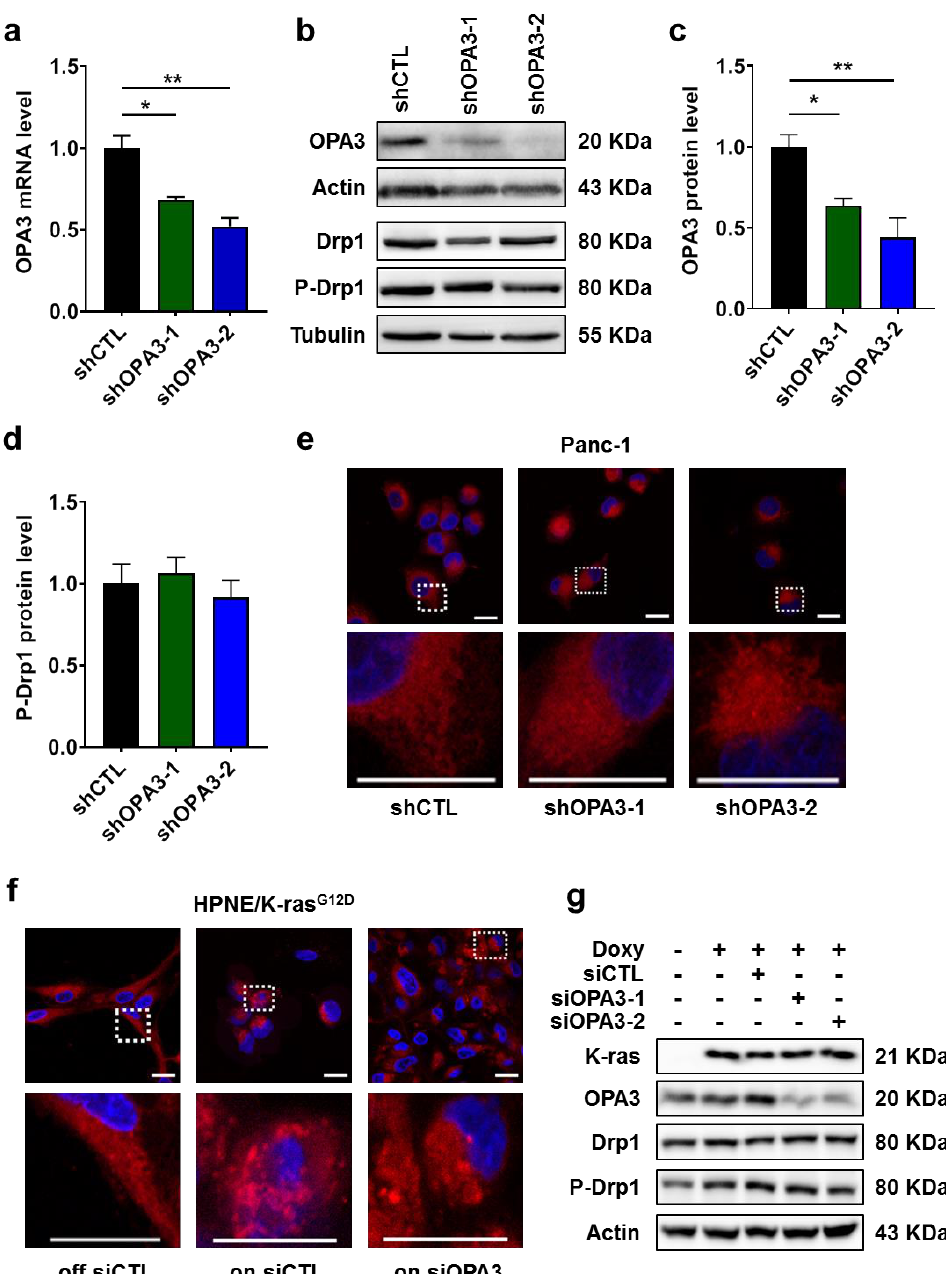
Figure 2. Silencing of OPA3 expression does not modify mitochondrial morphology: ( a ) OPA3 mRNA levels in Panc-1 OPA3-shRNA cell lines were measured by real-time PCR. ( b – d ) OPA3 and phospho-Drp1 (ser616) protein levels in Panc-1 OPA3-shRNA cell lines were analyzed by immunoblotting and quantified. ( e , f ) Mitochondrial morphology was analyzed with MitoTracker red probe in Panc-1 OPA3-shRNA cells and HPNE / K-ras G12D cells (with or without doxycycline and siRNA against OPA3). Scale bars represent 20 µ m ( g ) HPNE / K-ras G12D cell line was transfected with control siRNA (siCTL) or OPA3 for 48 h and then incubated with doxycycline for additional 48 h. K-ras, OPA3, Drp1, and phospho-Drp1 (ser616) protein levels were analyzed by immunoblotting. Statistics: data are mean ± S.E.M. (n = 3); one-way ANOVA followed by Dunnett post hoc test (compared to “shCTL”) for ( a ) and ( c , d ). * p < 0.05 and ** p < 0.01. Abbreviations: Drp1: dynamin related protein 1, K-ras: Kirsten RAS GTPase, OPA3: optic atrophy protein 3, shCTL: control shRNA, shOPA3: shRNA against human OPA3, siCTL: control siRNA, and siOPA3: siRNA against human